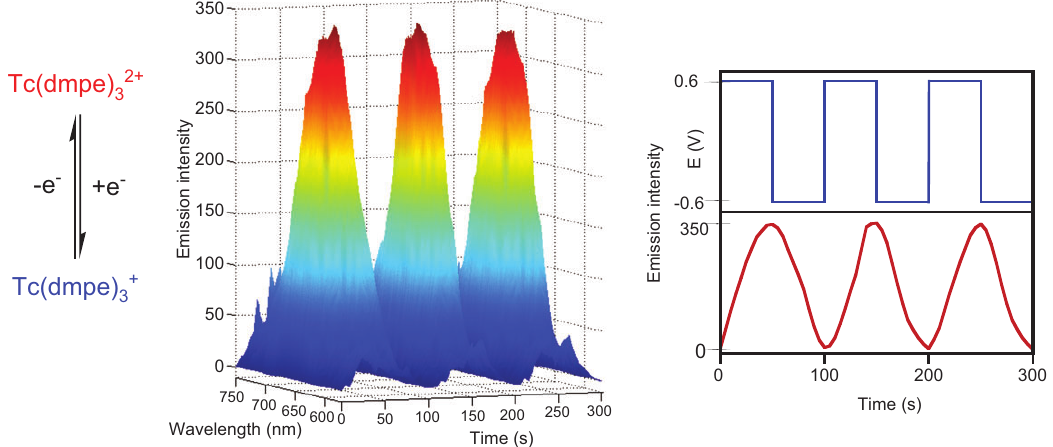
= 532 nm) upon reversible interconversion of [Tc(dmpe) Figure 13 Optical modulation profile (left) of emission intensity ( λ ] + (non-emis- ex 3 ] 2 + (emissive) on the application of varying step potential plotted vs. wavelength and time; and varying step potential sive) and [Tc(dmpe) 3 (right, top) and time of modulation of emission intensity (right, bottom) at 600 nm as a function of applied potential. Reprinted with permis- sion from “ Chatterjee, S.; Del Negro, A.S.; Edwards, M.K.; Bryan, S.A.; Kaval, N.; Pantelic, N.; Morris, L.K.; Heineman, W.R.; Seliskar, C.J. Anal. Chem. 2011 , 83 , 1766. ” Copyright © 2011, American Chemical Society.